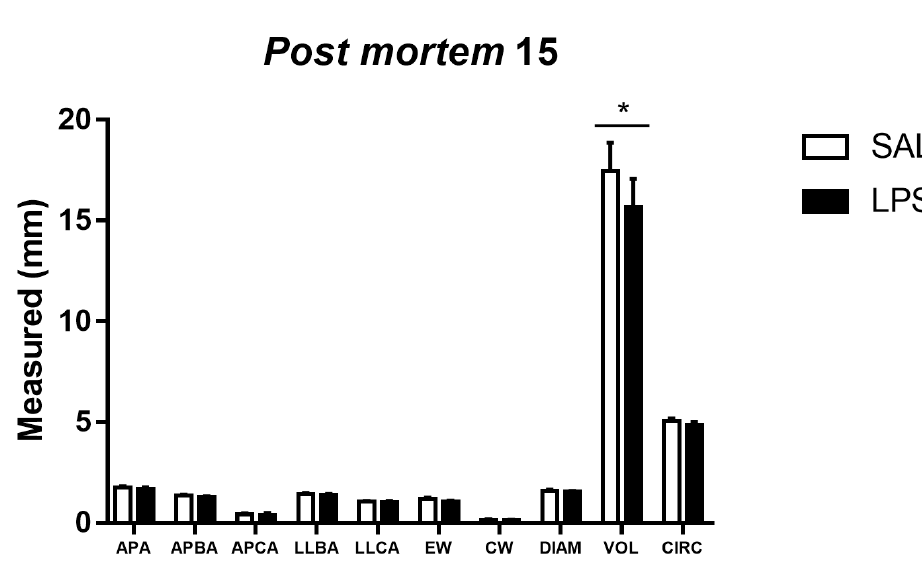
Figure 9. Effects of prenatal exposure to lipopolysaccharide (LPS), compared to the control group (SAL), on the development of rats: post mortem brain (n=23). The evaluation was performed on the 15th postnatal day. Data presented on average ± S.D. *p < 0.05. APEA = anterior-posterior encephalium axis; APBA = anterior-posterior brain axis; APCA = anterior-posterior cerebellum axis; LLBA = laterolateral axis of the brain; LLCA = laterolateral axis of the cerebellum; EW = encephalic weight; CW = cerebellum weight; DIAM = diameter; VOL = volume; CIRC = circumference.